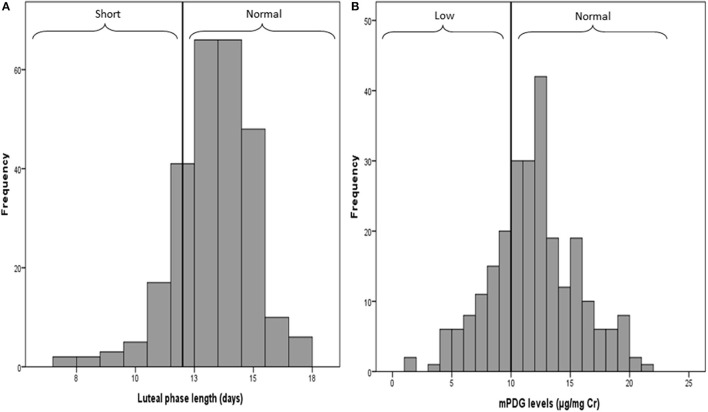
Distributions of the luteal phrase lengths (A) and the mean PDG levels (B). Values 12 and 10 are the thresholds used to define short vs. long luteal phase and low vs. high PDG level.